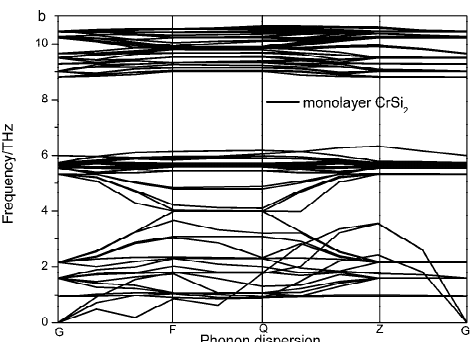
Figure 2. Phonon dispersion curves along the high-symmetry directions in the Brillouin zone of ( a ) bulk CrSi 2 , ( b ) monolayer CrSi 2 .